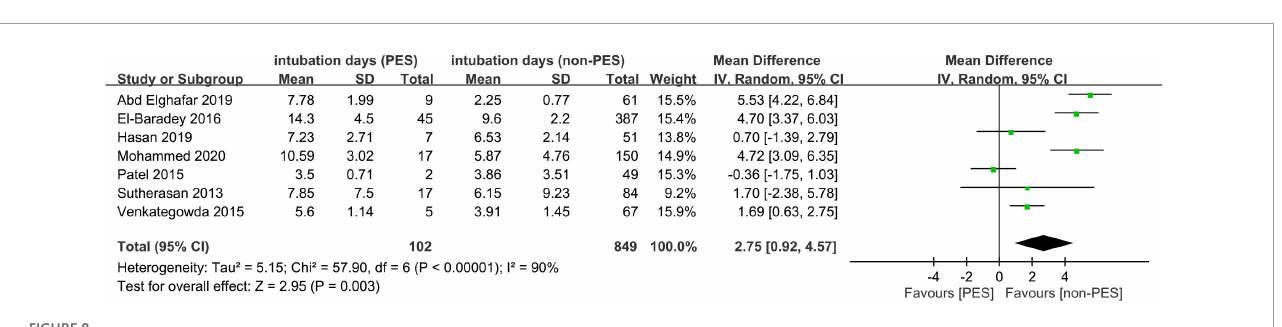
FIGURE8 Forest plot comparing intubation time between patients with and without post-extubation stridor (PES). CI, confidence interval.